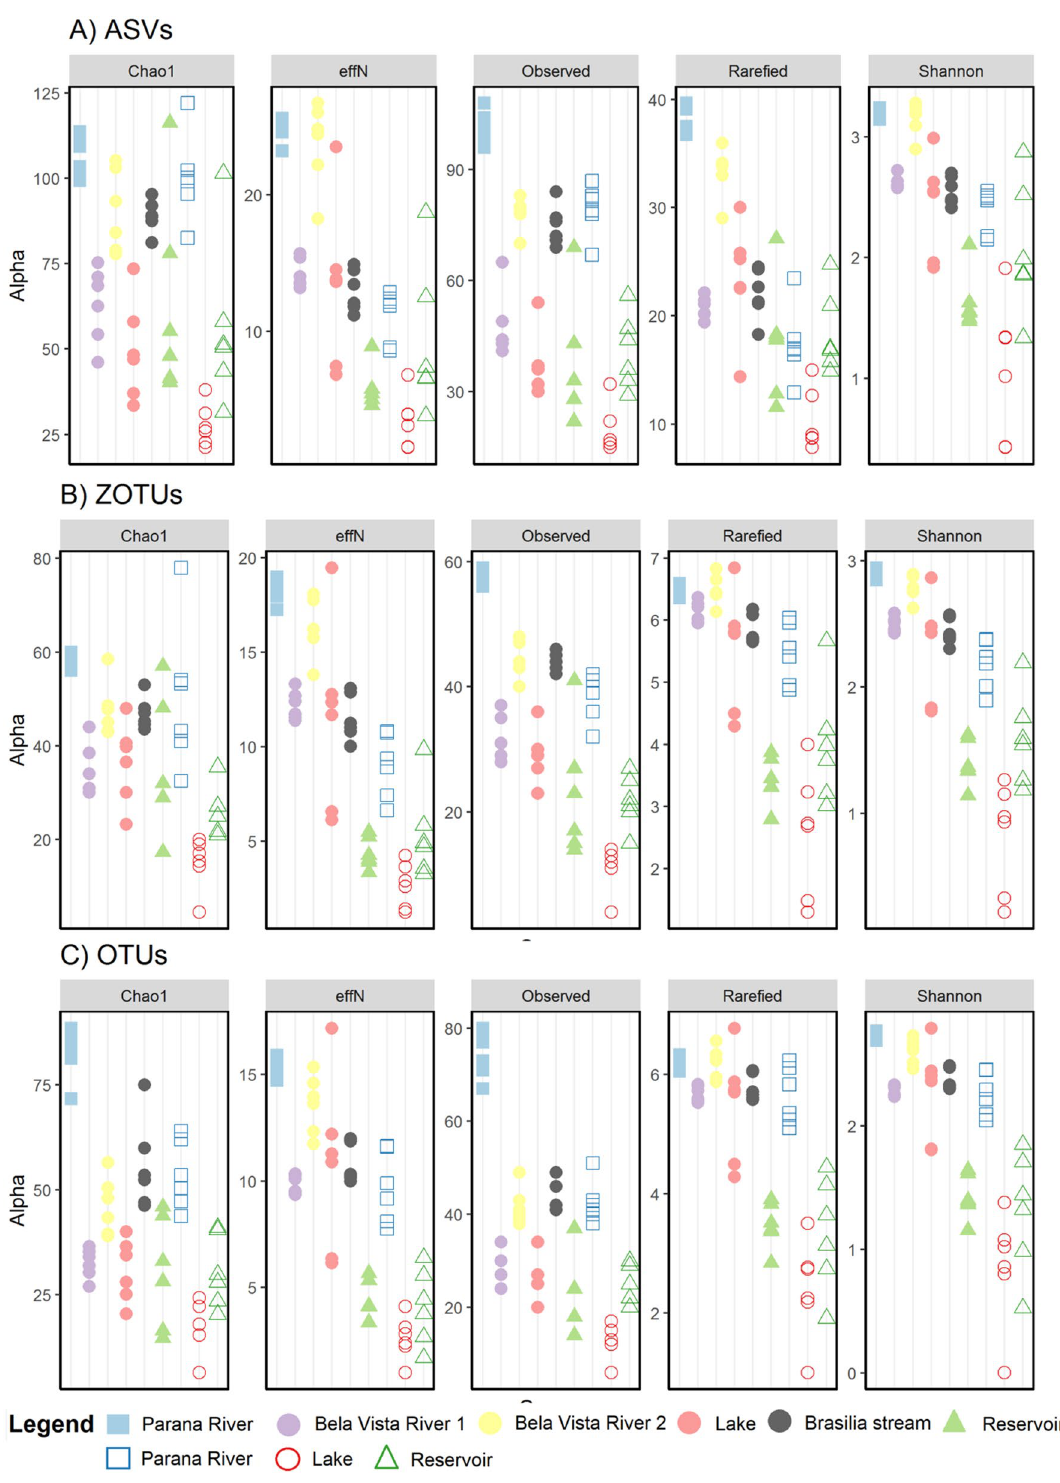
Figure 2. Alpha diversity estimation for ( A ) ASVs, ( B ) ZOTUs, ( C ) OTUS. Alpha diversity varied by location and by sampling year. Each point is one of the replicates sampled. Colors and symbols represent collection points (mouth of channel at Paraná River = blue square, Itaipu’s reservoir = green triangle, and Piracema Channel = circles [Bela Vista River 1 = purple, Bela Vista 2 = yellow, Brasilia stream = gray, and lake = red]), and fill represent year of collection (filled = 2019, empty =